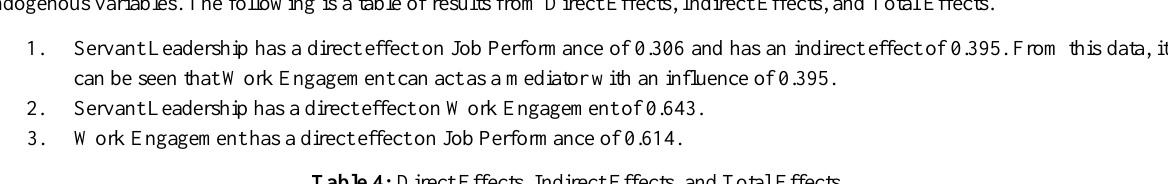
Table 4: Direct Effects, Indirect Effects, and Total